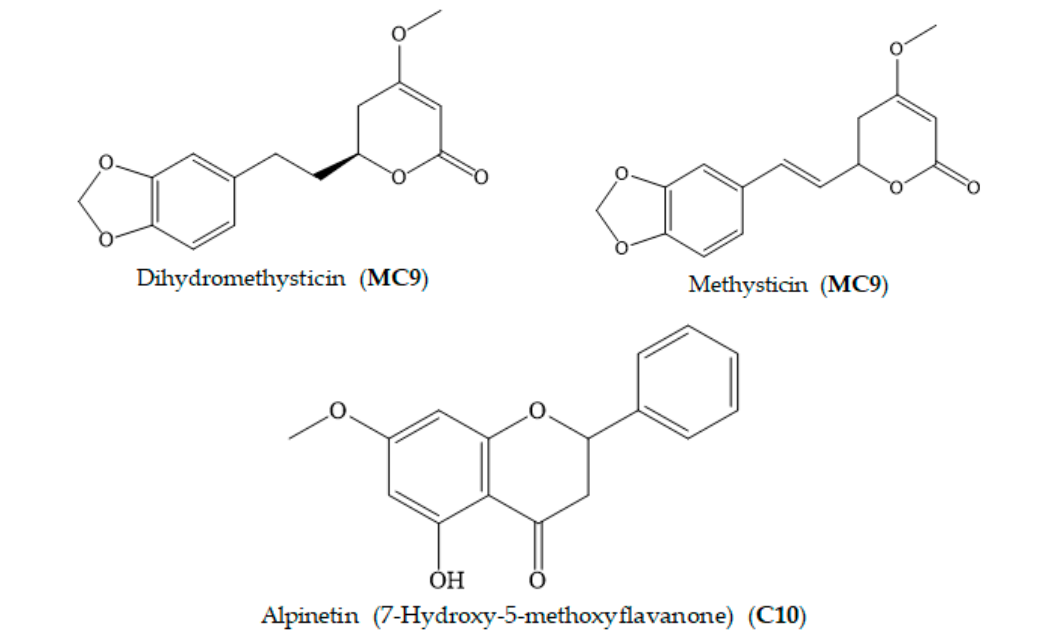
Figure 2. Chemical structures of components isolated from P. methysticum root. Table 2. Xanthine oxidase inhibitory and antioxidant activity of kava root extracts as IC 50 values.